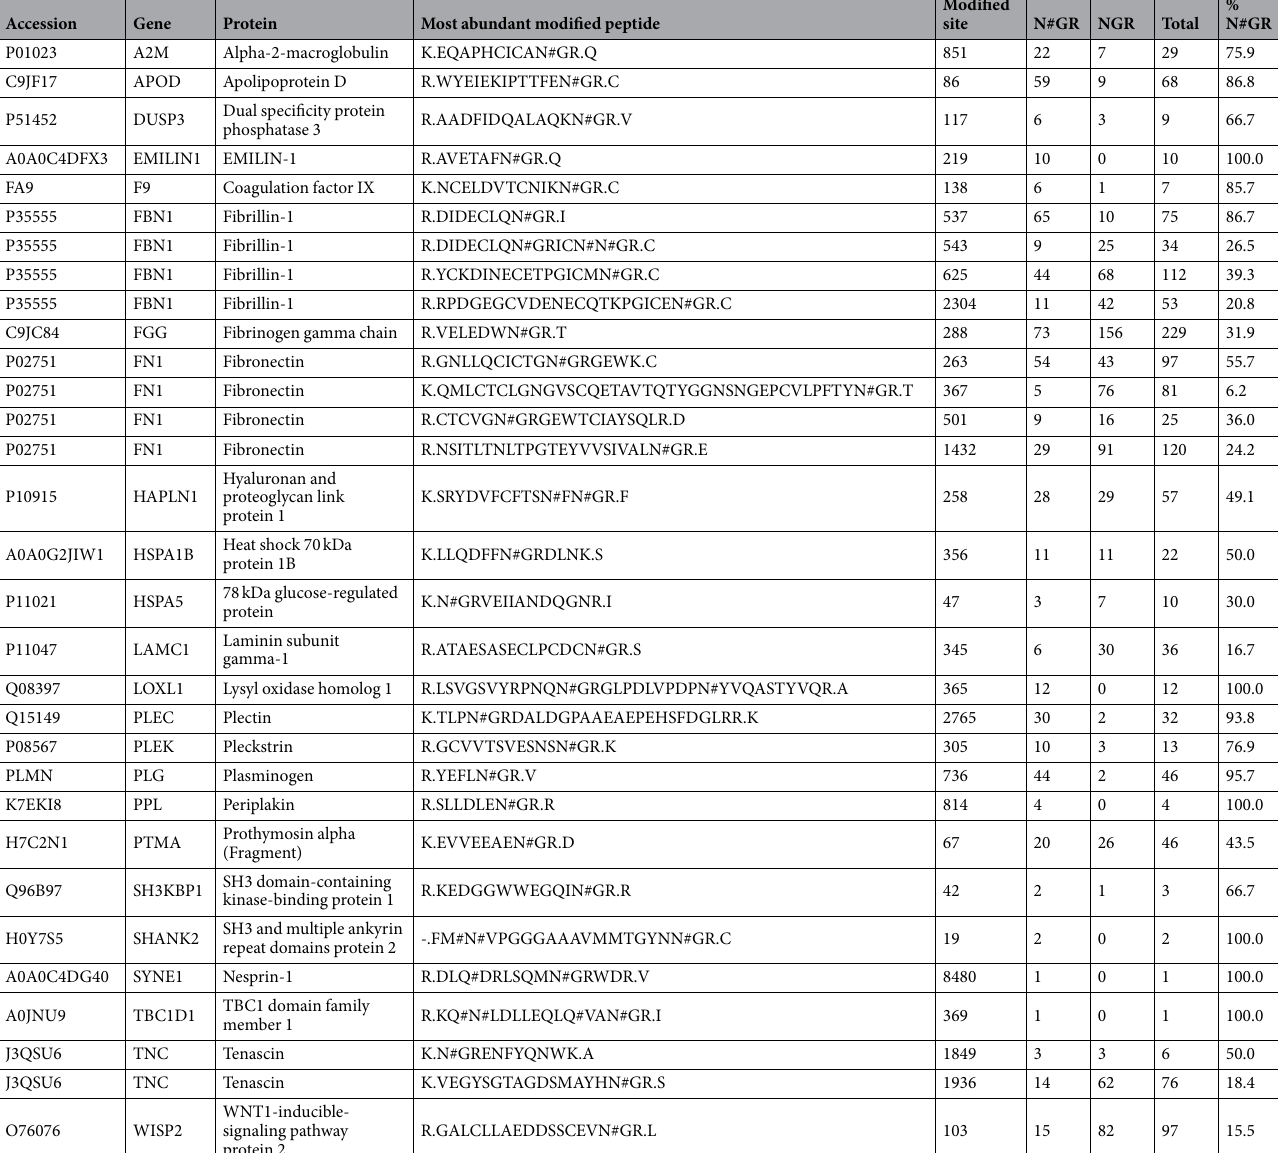
Table 1. IsoDGR-containing peptides identified by LC-MS/MS analysis of human carotid atherosclerotic